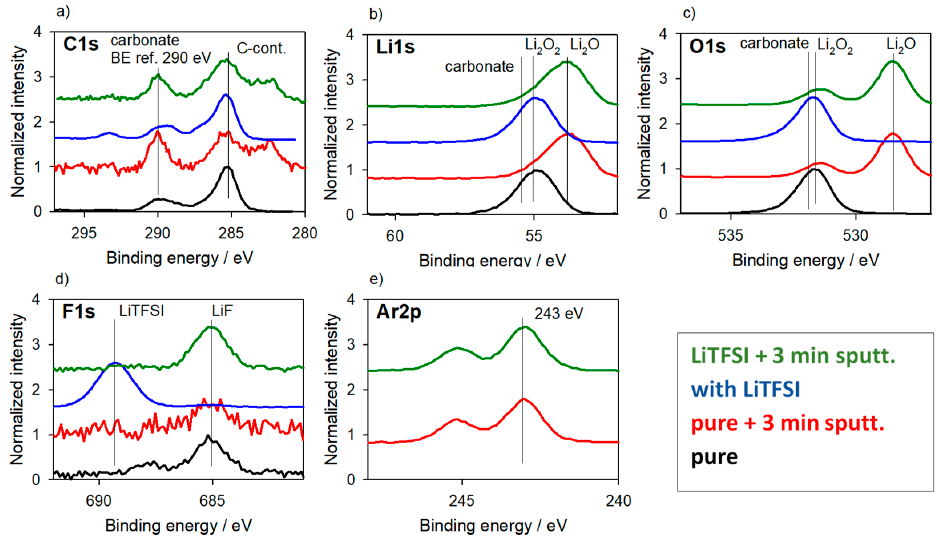
Figure 12. XP spectra normalized in intensity of pure and 20 h LiTFSI treated Li 2 O 2 powder without and with long-time sputter cleaning ( bottom to top ). Similar to Figure 11 the BE was corrected to carbonate residuals for C1s at 290 eV. A decomposition of Li 2 O 2 to Li 2 O is observed. ( a ) C1s; ( b ) Li1s; ( c ) O1s; ( d ) F1s; ( e ) Ar2p transition.